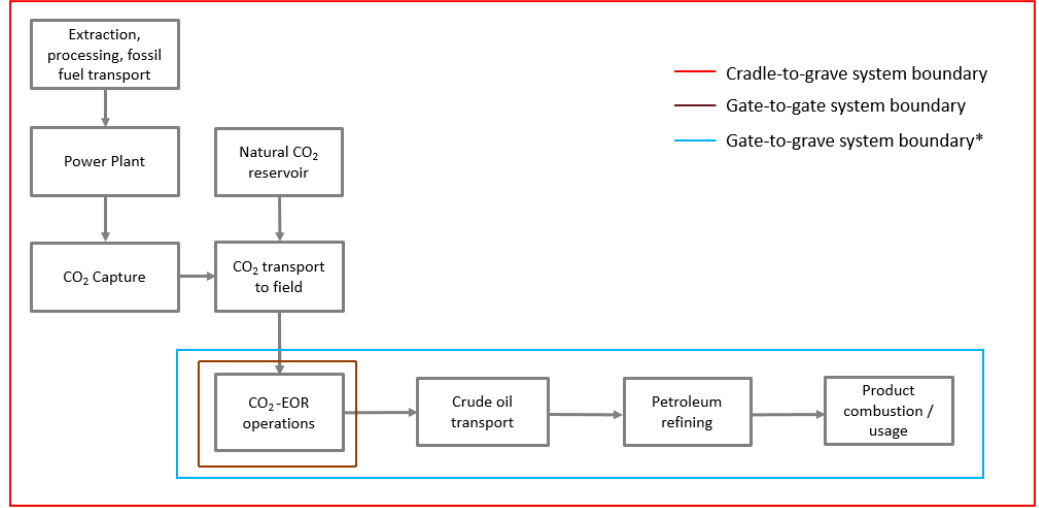
Figure 2. Carbon capture, utilization, and storage (CCUS) system components and carbon lifecycle analysis (LCA) boundaries. * Study boundary.